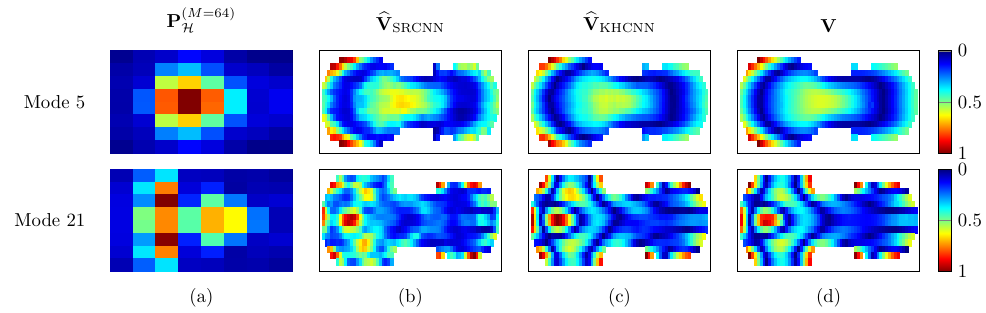
Figure 11. Reconstruction examples of SRCNN and KHCNN for two different violin top plates. The first and second row show the magnitude vibration of mode 5 and 21 at 264Hz and 948Hz, respectively. Column ( a ) is the input pressure at the hologram in M = 64 points. The SRCNN and KHCNN velocity estimates are depicted in column ( b , c ), respectively. Column ( d ) shows the magnitude velocity ground truth coming from